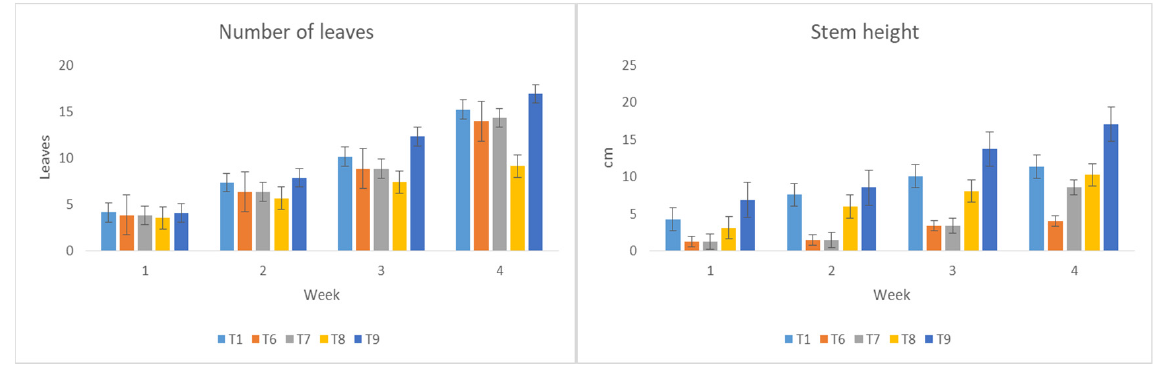
Figure 7. The morphological responses for T1, T6, T7, T8, and T9.